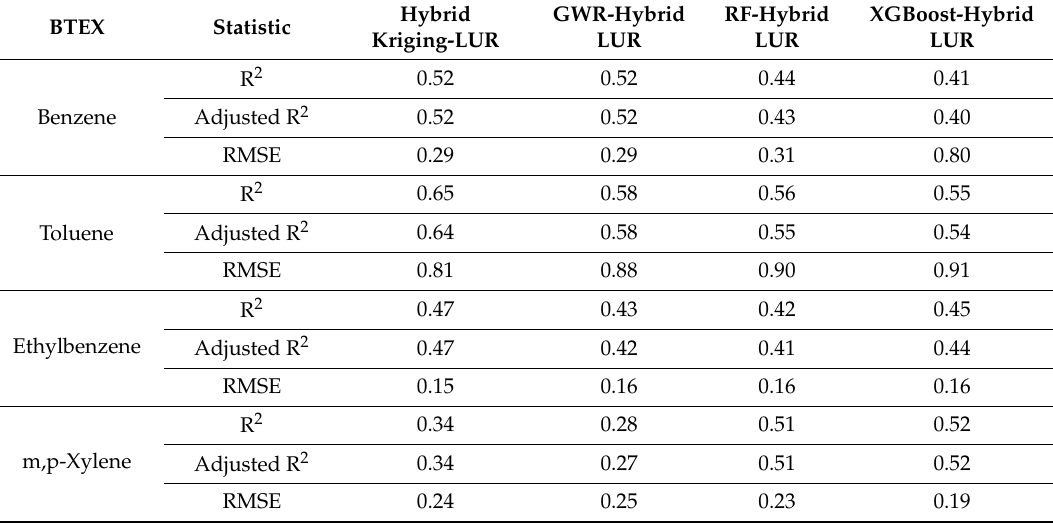
Table 3. External data validation for the proposed models.